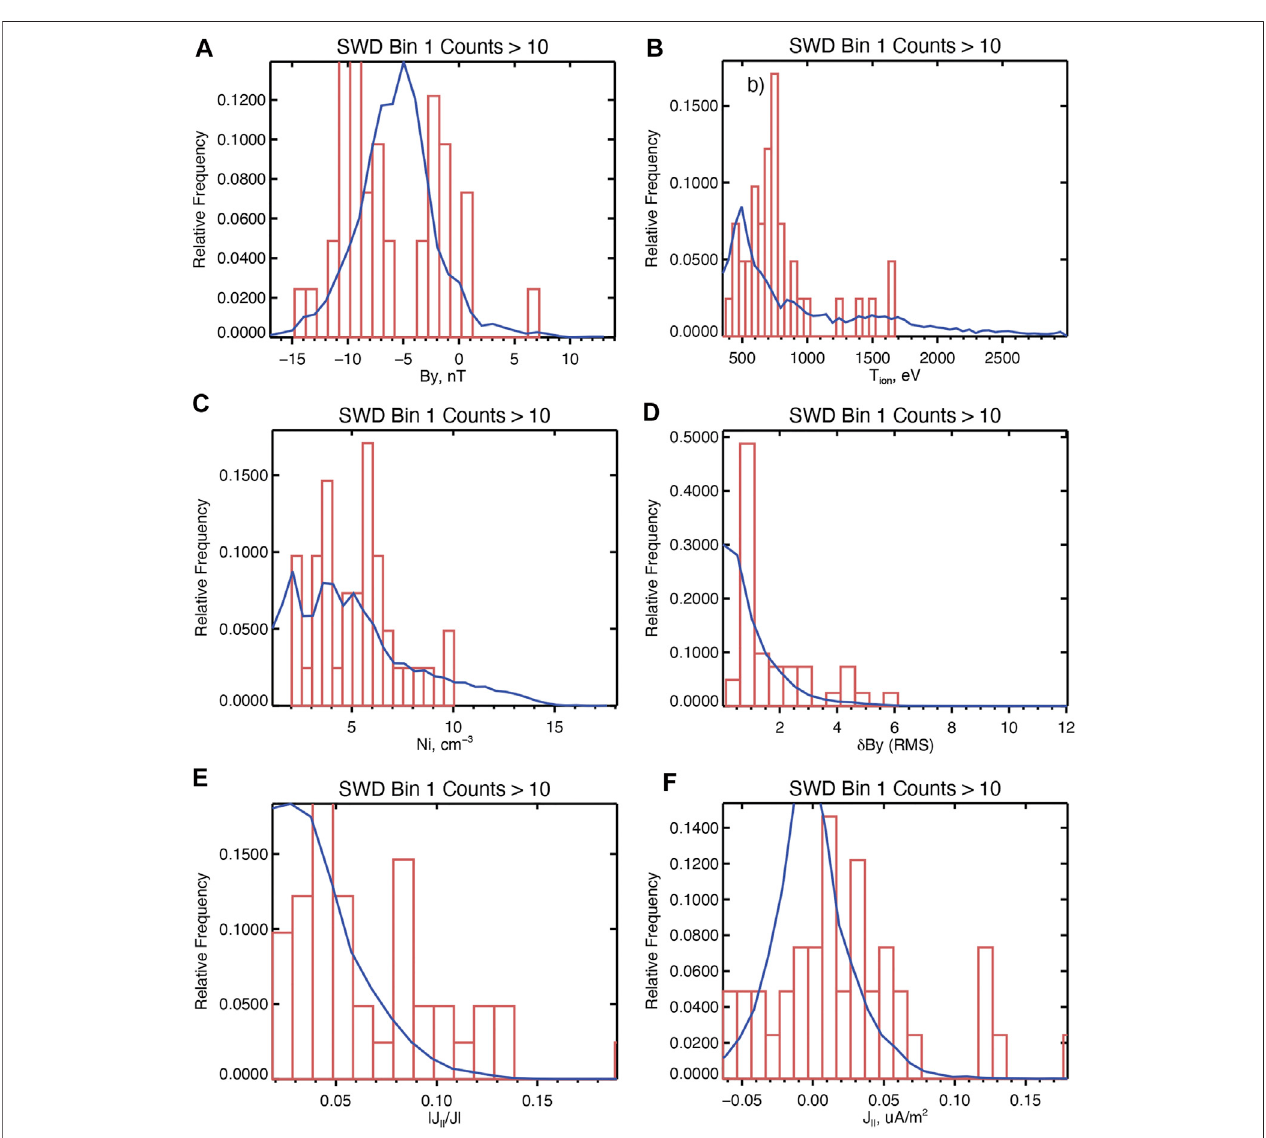
FIGURE12| Histogramsofmagnetic fi eldandplasmaquantitiesduringtheSeptember26,2017burstinterval,giveninthesameformatas Figure4 . (A) Magnetic fi eld GSE B Y , (B) Ion temperature, T ion , (C) Ion number density, N i , (D)